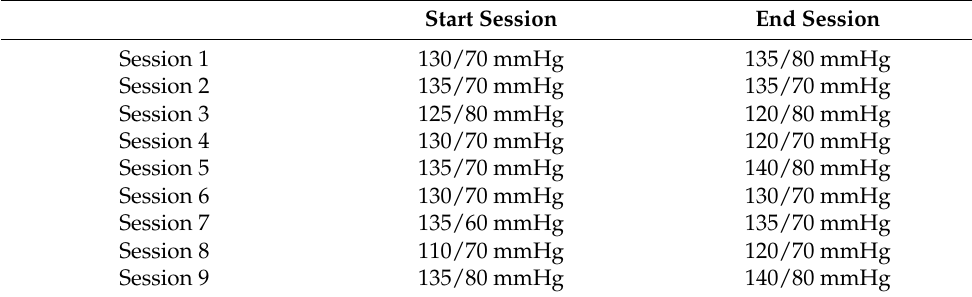
Table 3. Trend of blood pressure values.